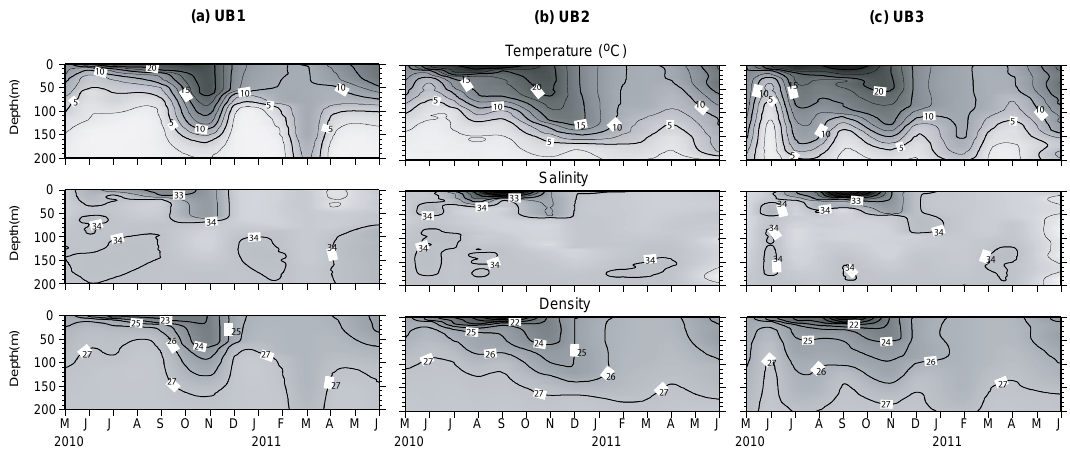
Fig. 2. Contour plots of physical parameters (temperature ( ◦ C), salinity, and density ( σ t ) ) observed at the three stations during our study period. Figure 2. Contour plots of physical parameters [temperature (  C), salinity, and density (σ observed at the three stations during our study period. 4